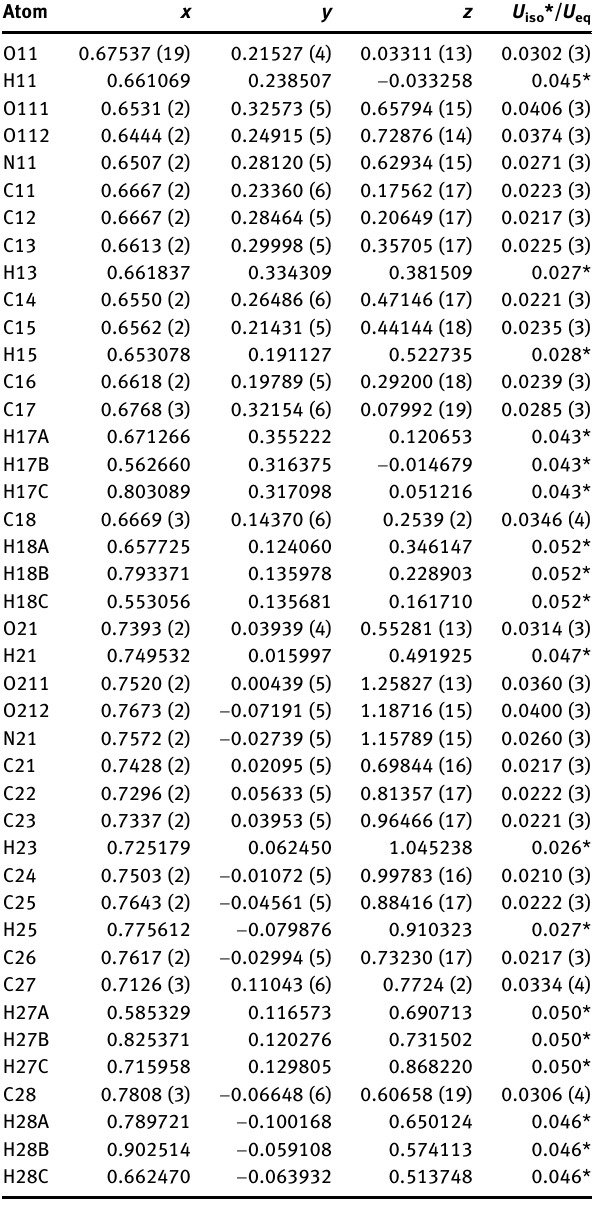
Table  : Fractional atomic coordinates and isotropic or equivalent isotropic displacement parameters (Å 